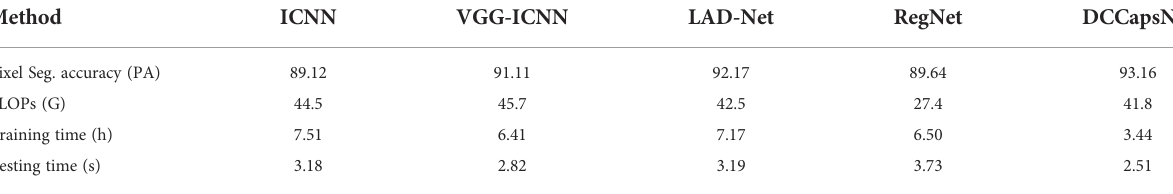
TABLE 3 The recognition results of ICNN, VGG-ICNN, LAD-Net, RegNet, and DCCapsNet. Method